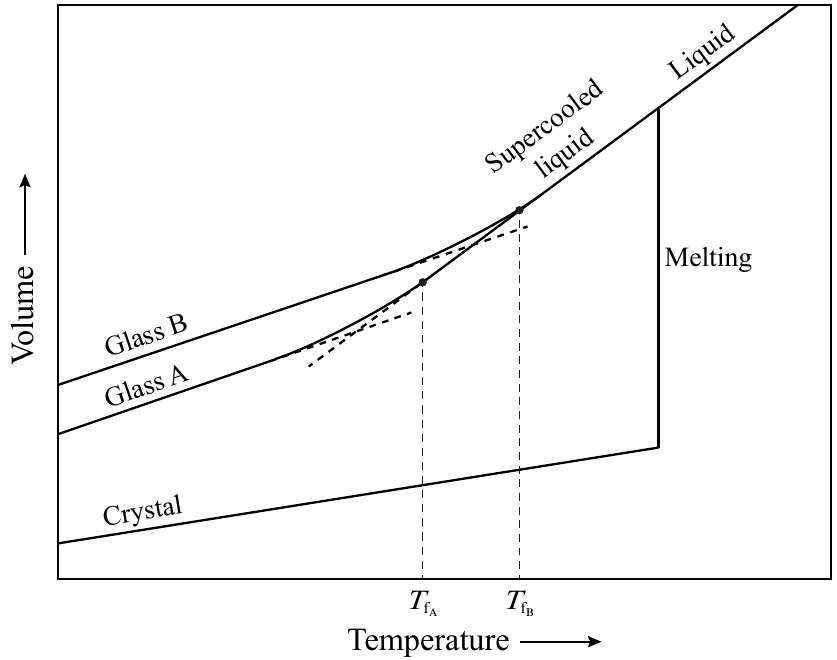
Figure 4. Volume–temperature diagram representing the solidification of melted silica into crystalline or glassy SiO 2 . The supercooled liquid can be cooled at different quenching rates to produce glasses with varying fictive